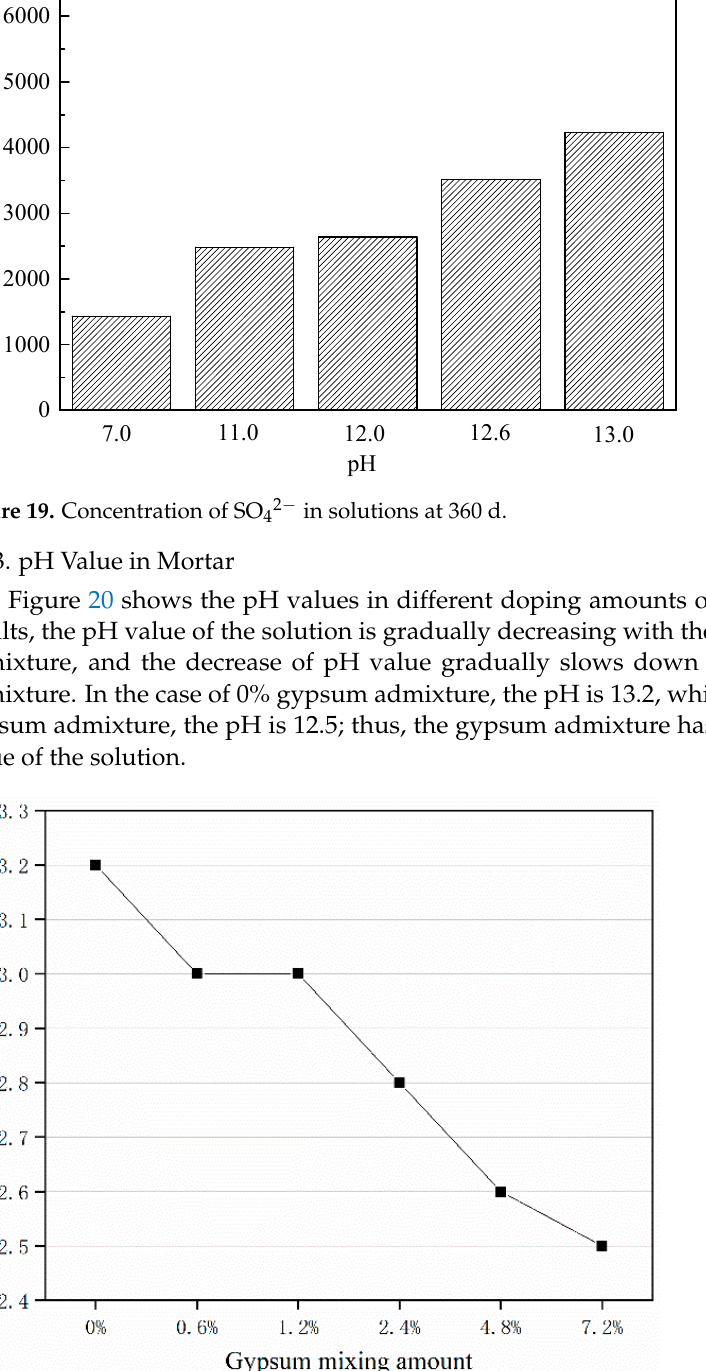
Figure 20. Effect of gypsum dosing on pH value.